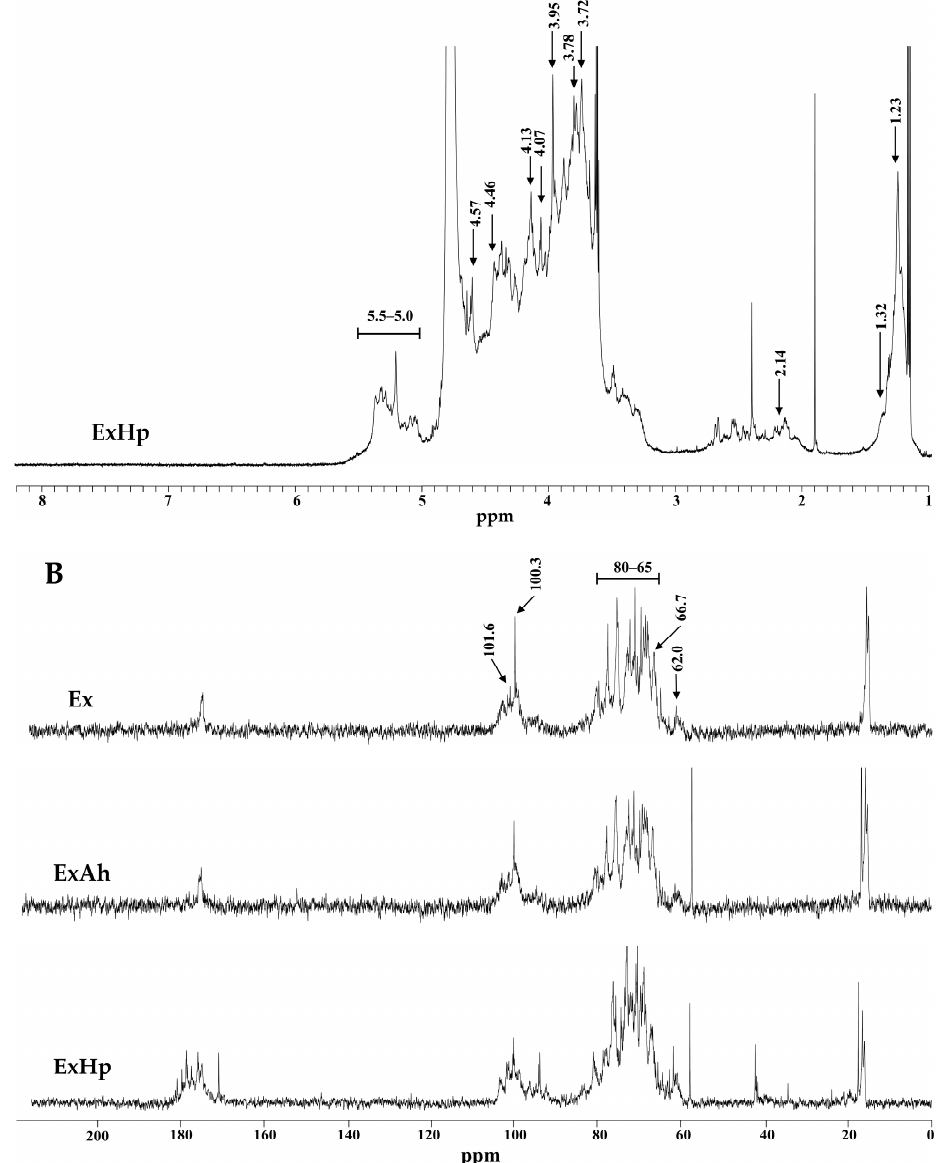
Figure 2. NMR spectra for Ex, ExAh, and ExHp. ( A ) 1 H-NMR of Ex, ExAh, and ExHp and ( B ) 13 C-NMR of Ex, ExAh, and ExHp. The characteristic peaks are indicated in each graph.